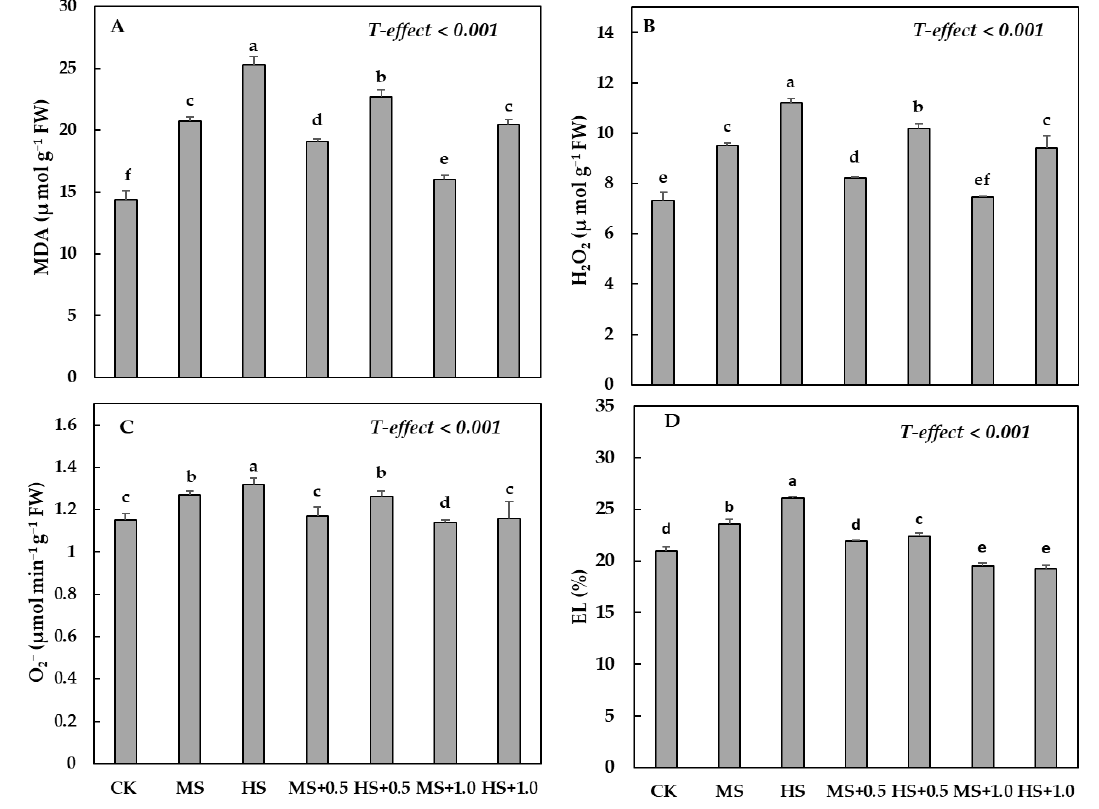
Figure 2. The mean contents/concentration of MDA ( A ), H 2 O 2 ( B ), O 2 − ( C ) and EL percentage ( D ) under MS, HS, MS + 0.5, HS + 0.5, MS + 1.0 and HS + 1.0 in M. alba saplings. Small letters represent significant differences between the treatment means (T-effect) at p < 0.05.